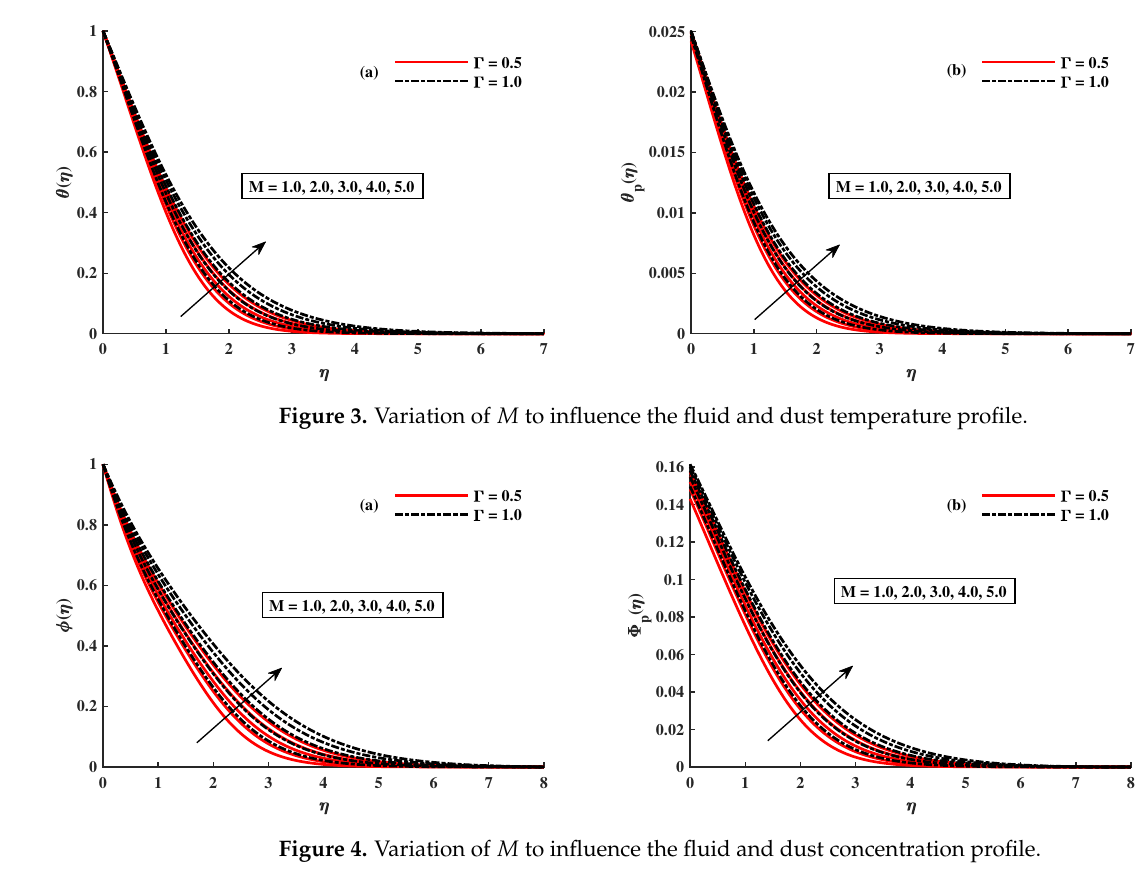
Figure 4. Variation of M to influence the fluid and dust concentration profile.